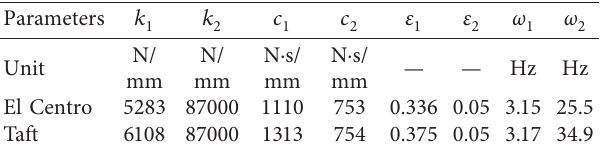
Table 4: Kinetic parameters when T peak acceleration is 0.4 g .